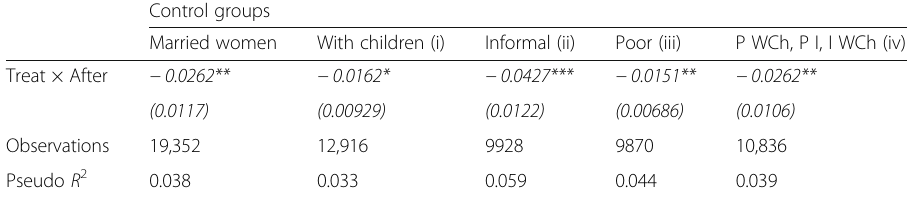
Table 5 Effect of AUH on the probability of entering the labor force. Alternative control